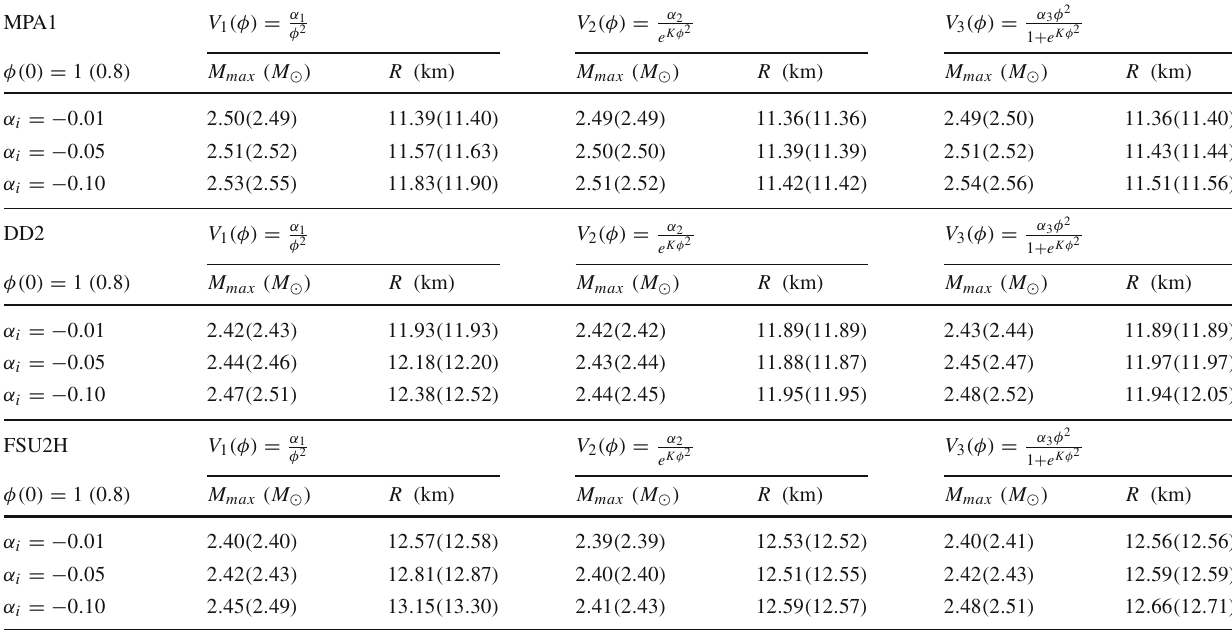
Table 3 M max and corresponding radius for relativistic EoSs with K = 0 . 5, φ( 0 ) = 1 (φ( 0 ) = 0 . 8 ) and various α i ( i = 1 .. 3 )